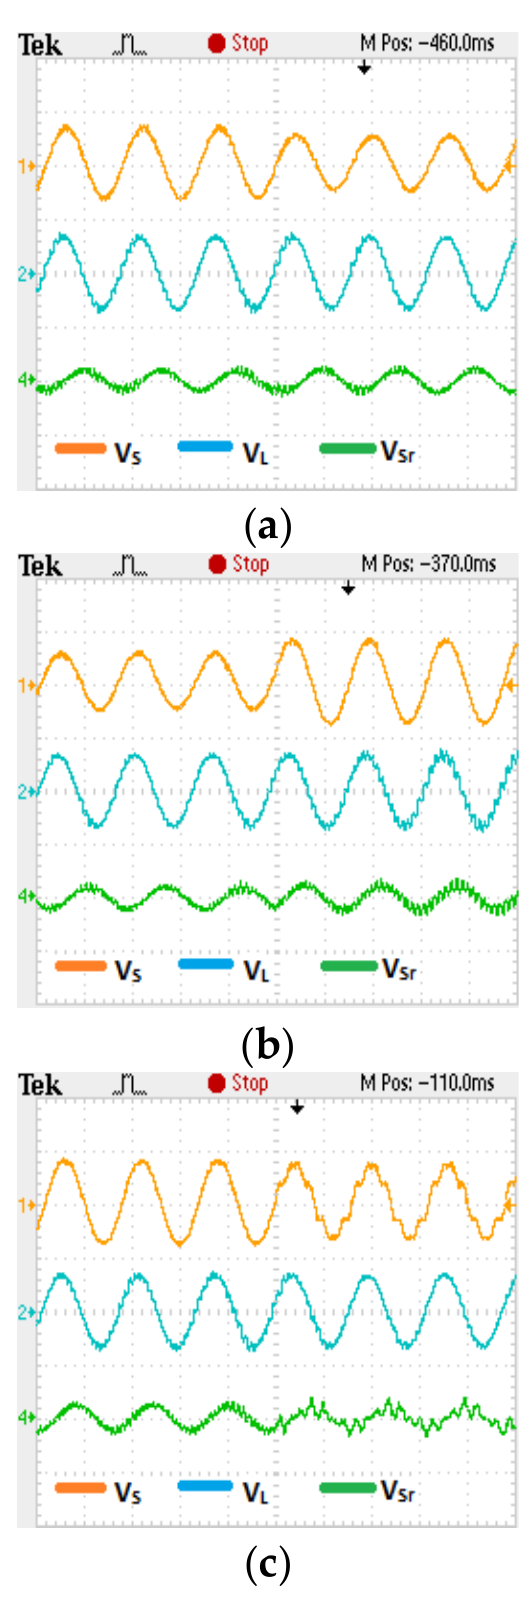
Figure 14. OPAL-RT results of source voltage (V S ), load voltage (V L ) and series injected voltage (V Sr ) for different disturbance conditions: ( a ) normal to sag; ( b ) sag to swell; ( c ) swell to normal with harmonics.